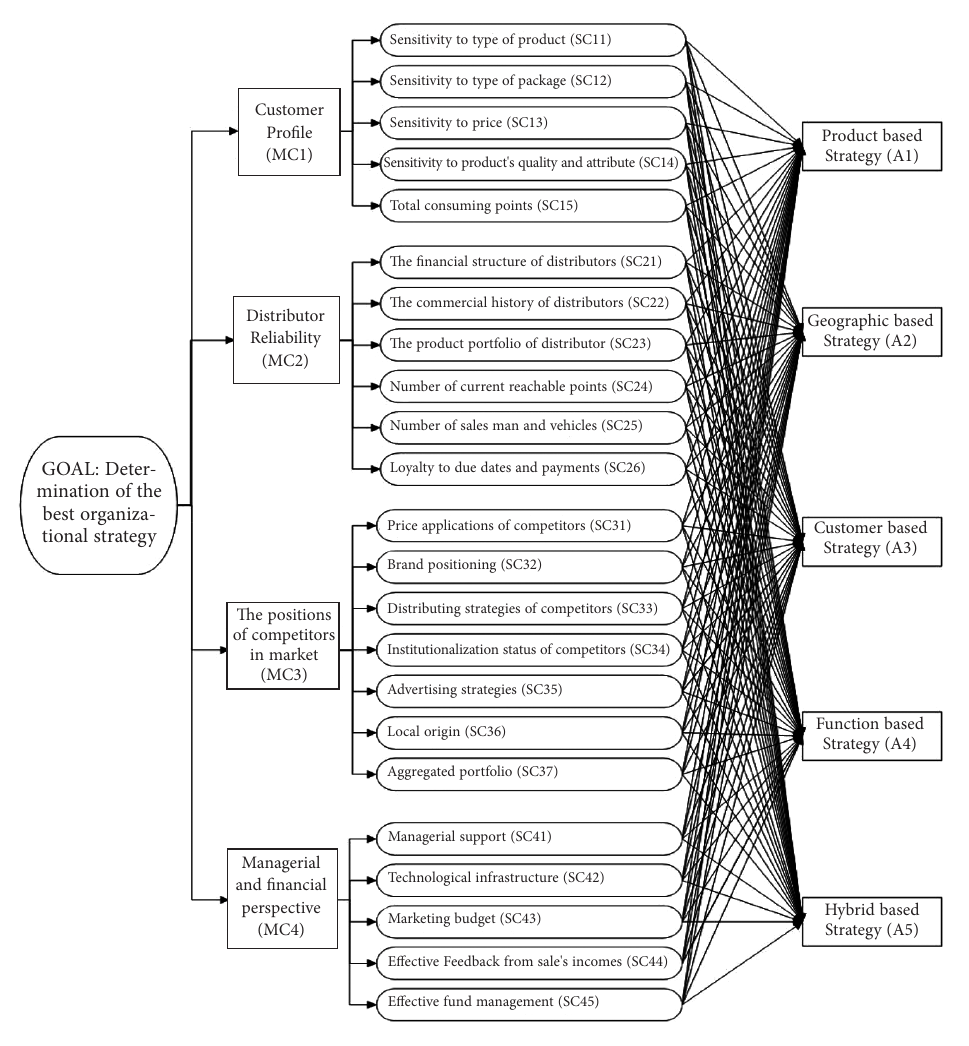
Figure 2. Hierarchical structure of the organizational strategy